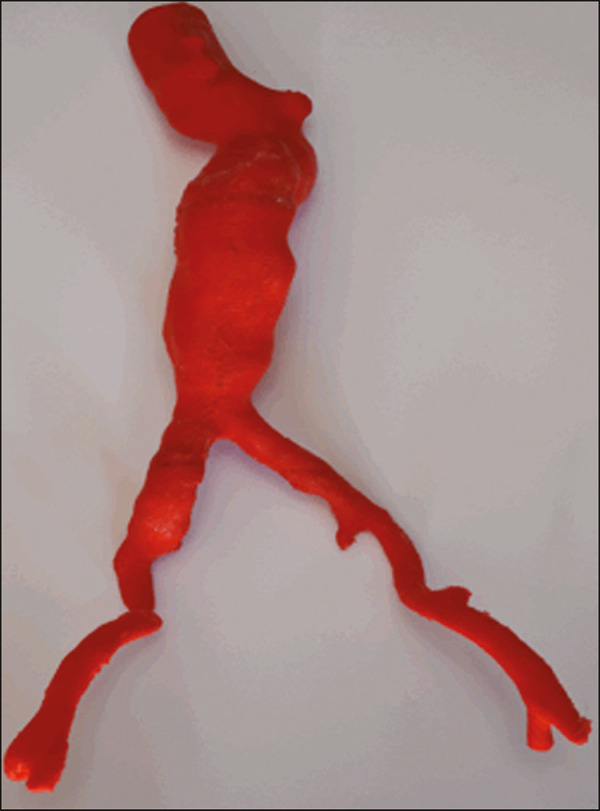
Biomodel after removal of the supports and excess glue.